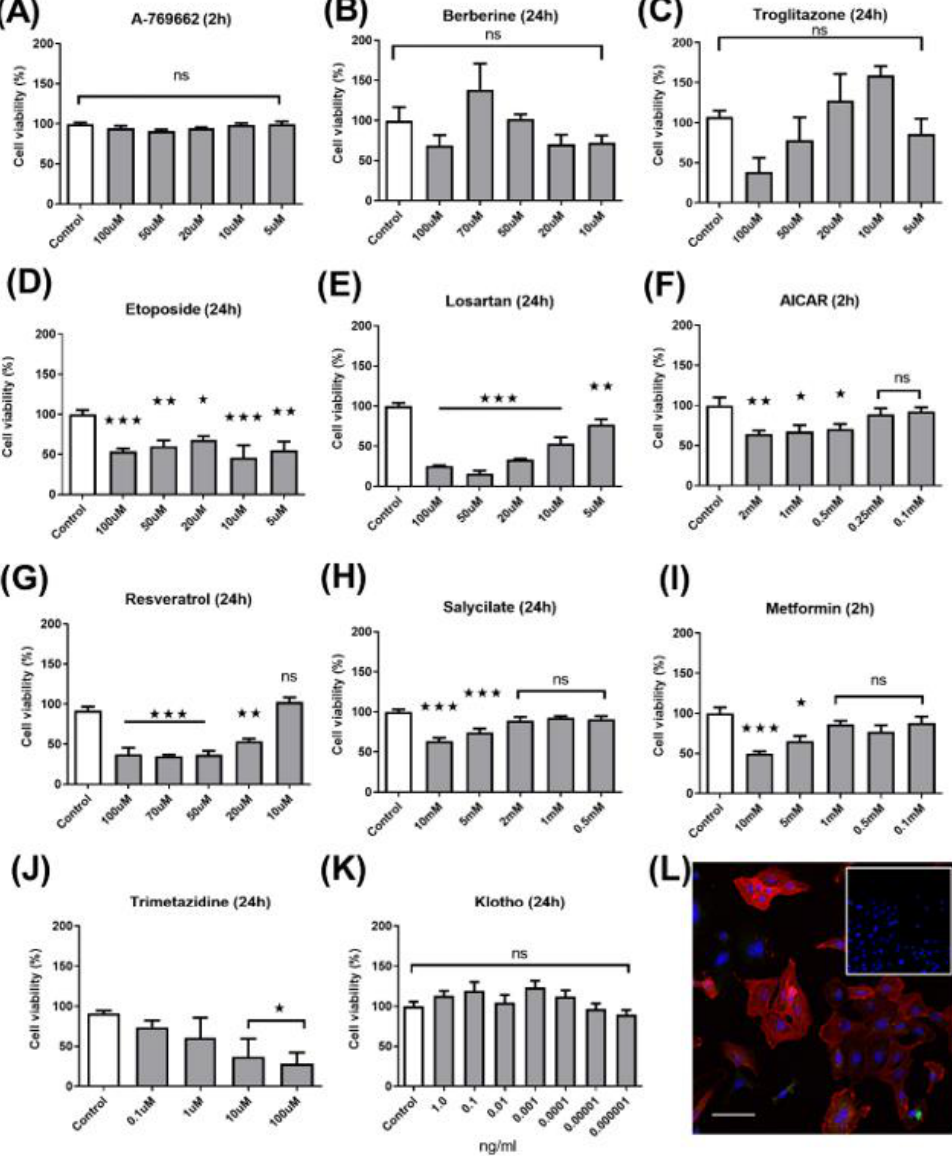
Figure 1. Cytotoxicity to screen acute and chronic dose-response. A screen of potential energetic switching compounds was performed. Both chronic (24 h) and acute (2 h) dosing regimens were tested in wild-type cells and rate of XTT conversion was used as an index of both mitochondrial health and viability. Survival was compared with no drug carrier controls: ( A ) A769662; ( B ) berberine; ( C ) troglitazone; ( D ) etoposide; ( E ) losartan; ( F ) AICAR; ( G ) resveratrol; ( H ) salicylate; ( I ) metformin; ( J ) trimetazidine; ( K ) Klotho; ( L ) confocal immunofluorescent imaging of the AMPK downstream marker acetyl–CoA carboxylase in explant VSMCs that are α -SMA positive (inset secondary anti- body control) was used as a recognised surrogate marker of AMPK activity. (Scale 100 µ M) and confirm VSMC status One-way ANOVA with Dunnett’s post hoc test ( n = 4), * p ≤ 0.05, ** p ≤ 0.01, *** p ≤